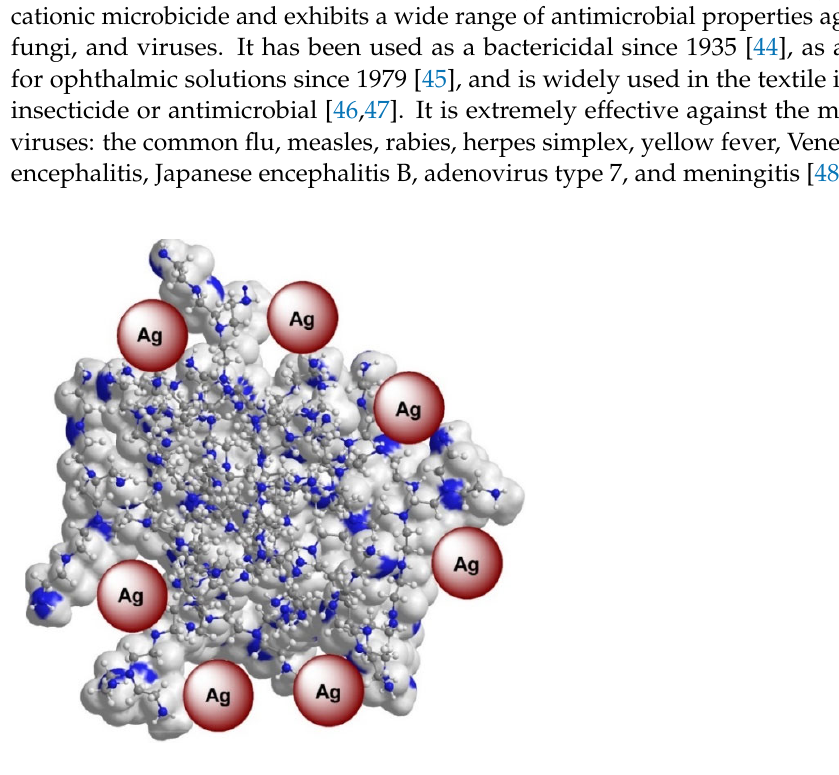
Figure 1. Schematic representation of Ag Nps nucleation inside the cavities of hyperbranched PEI. On the outer surface of PEIs, the functional primary amino groups are capable